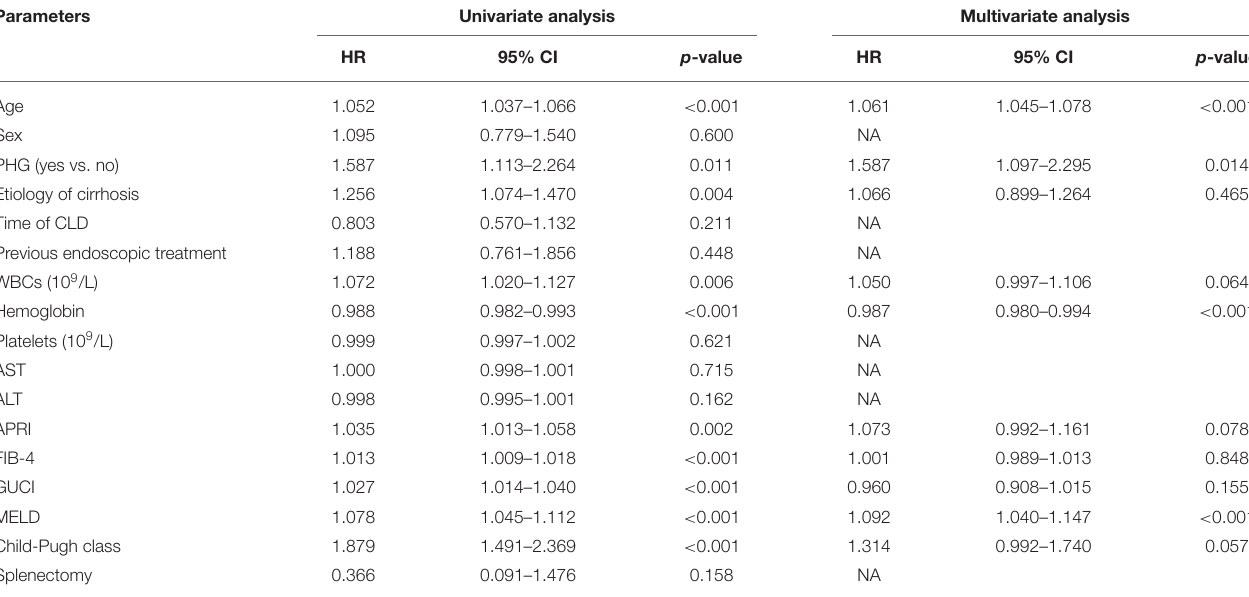
TABLE 2 | Cox regression analysis demonstrating the association between variables and OS.